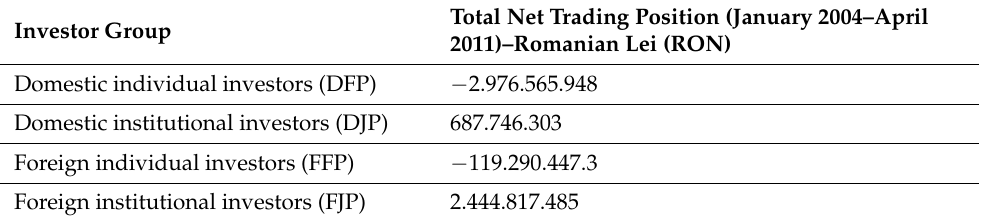
Table 2. Total net trading position of different investor groups on BVB.